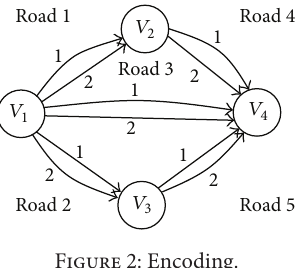
Figure 2: Encoding.